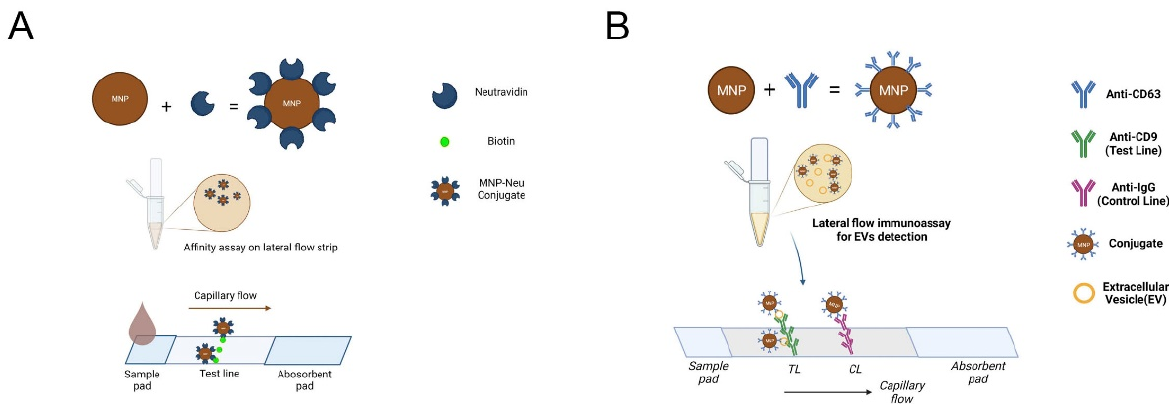
Figure 1. Schematic representation of the ( A ) lateral flow affinity assay (biotin–neutravidin) and the ( B ) lateral flow immunoassay for EV detection, using MNPs as reporter labels. Figure 1 was created using biorender.com.